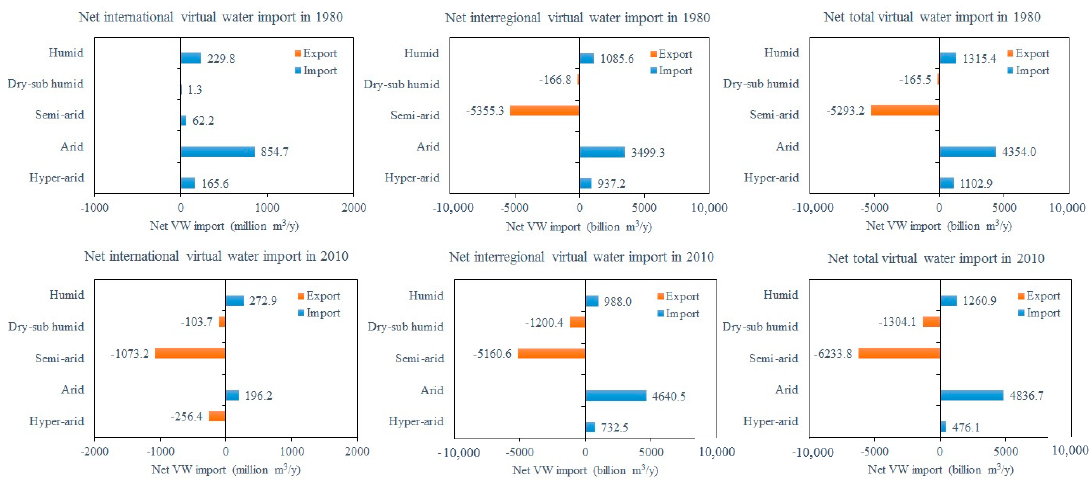
Figure 12. Net international, interregional, and total virtual water import per climatic region in 1980 ( top ) and 2010 ( down ).